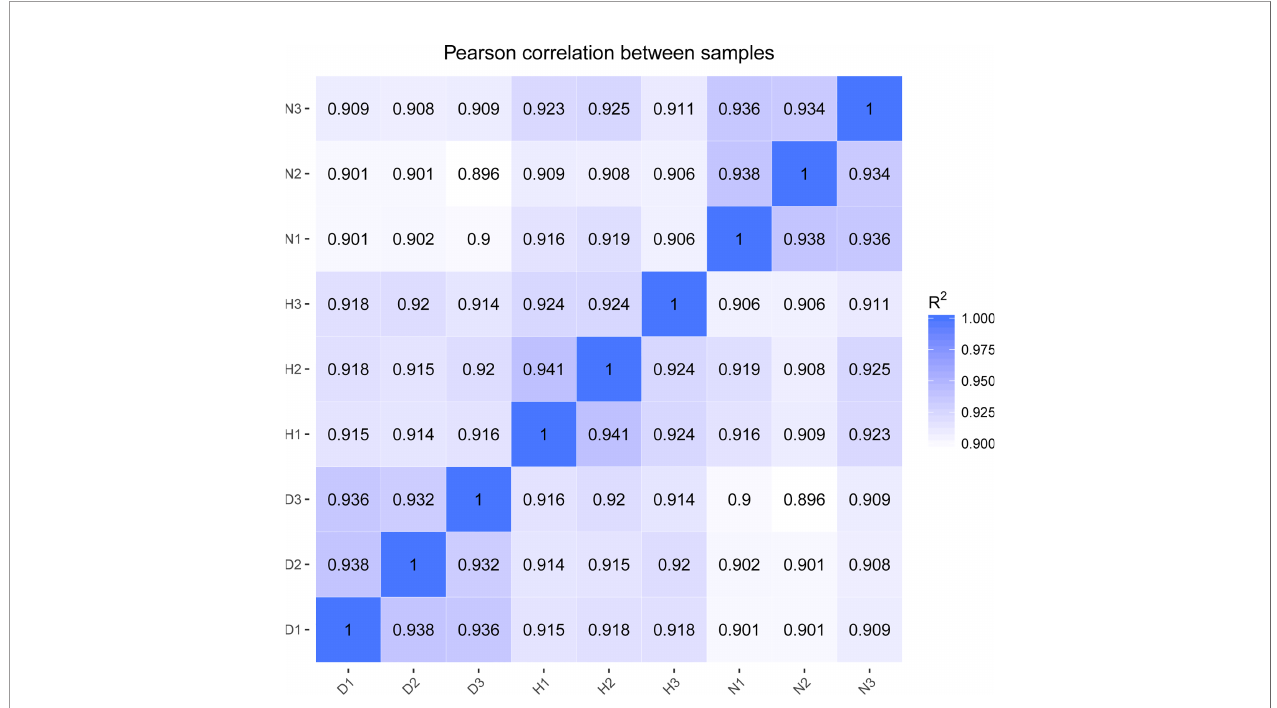
FIGURE 2 | Heatmap shows Pearson ’ s correlation of expression levels between